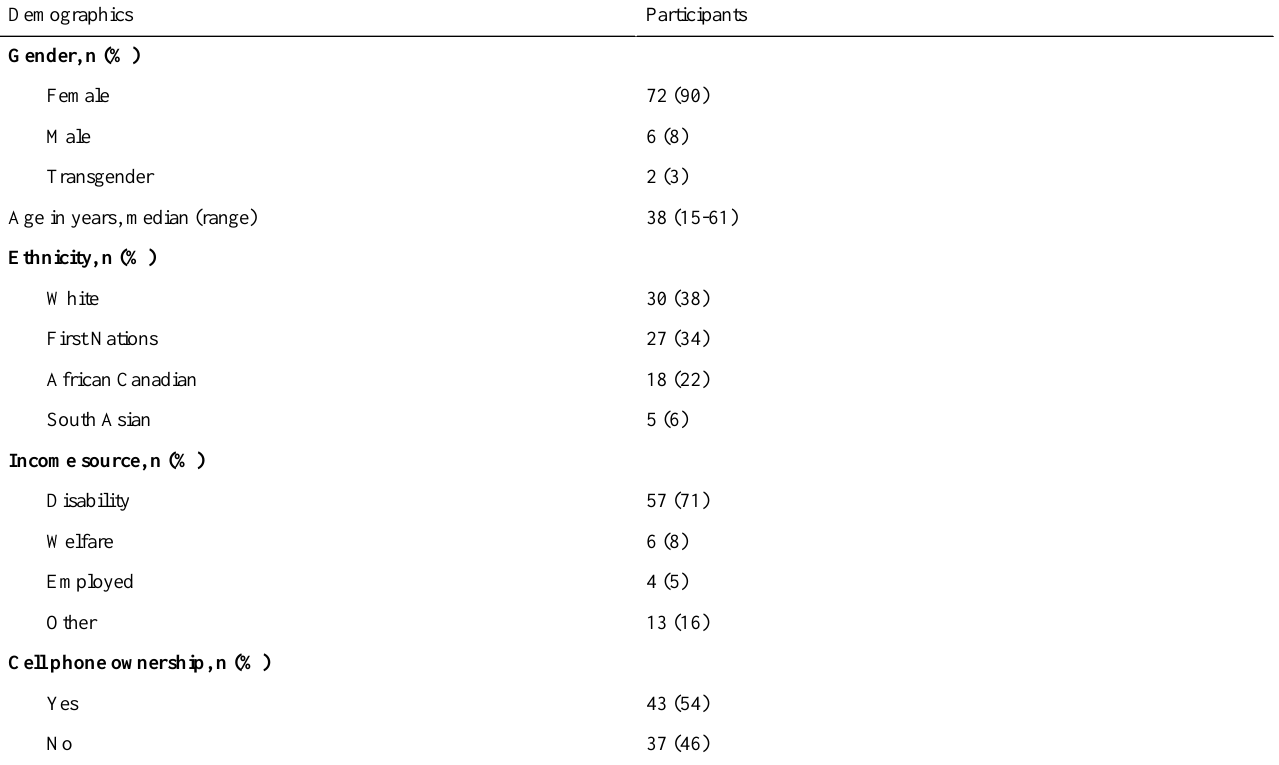
Table 1. Baseline demographics of a high-risk Canadian HIV-positive cohort